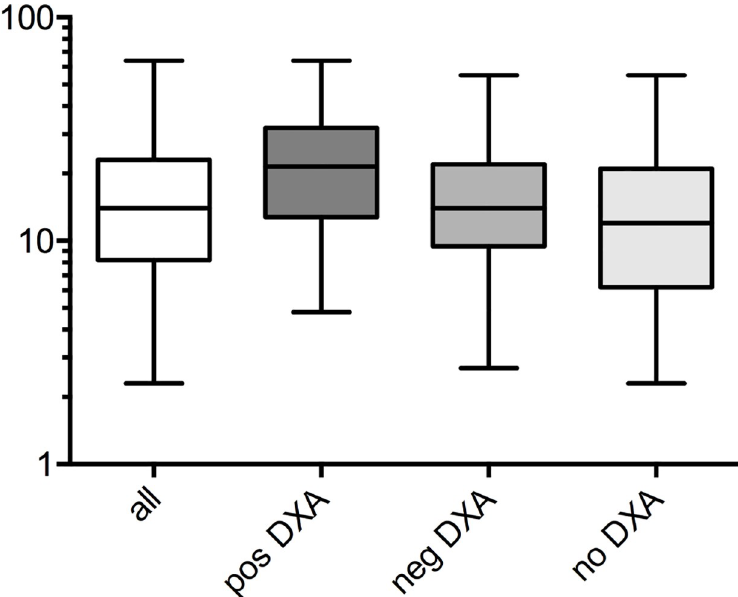
Fig 3. 10-year probability (mean, min-to-max and standard deviation) based on the FRAX-tool in all patients, with positive and negative result in DXA and no BMD measurement using DXA.